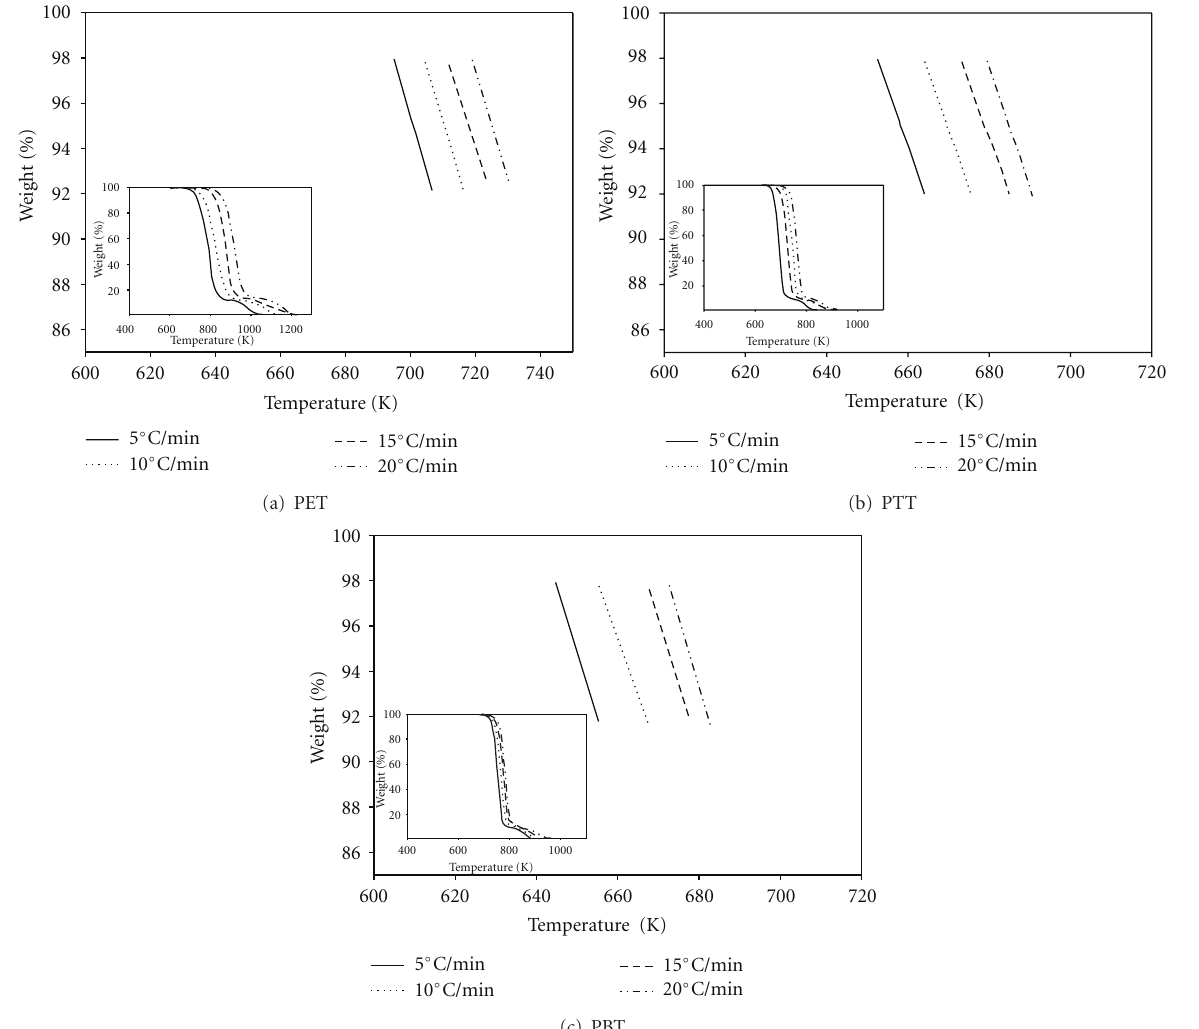
Figure 1: Plot of weight loss (2–8% conversion range) as a function of temperature for polyester degradation in air atmosphere (zone 1).